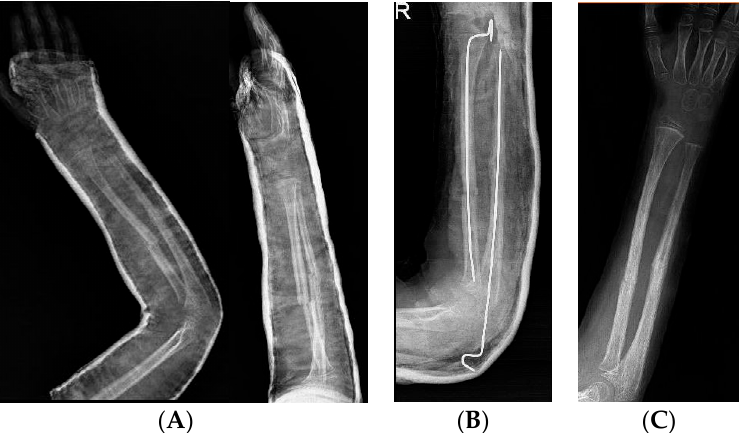
Figure 3. ( A ): Five-year-old patient treated with nonoperative treatment; after 4 months, they presented a displaced oligotrophic nonunion with pain and range of motion (ROM) deficit. ( B ): He was treated by cruentation of the fracture’s sites, reduction, stabilization with k wires, and cast. ( C ): Post k-wires removal.